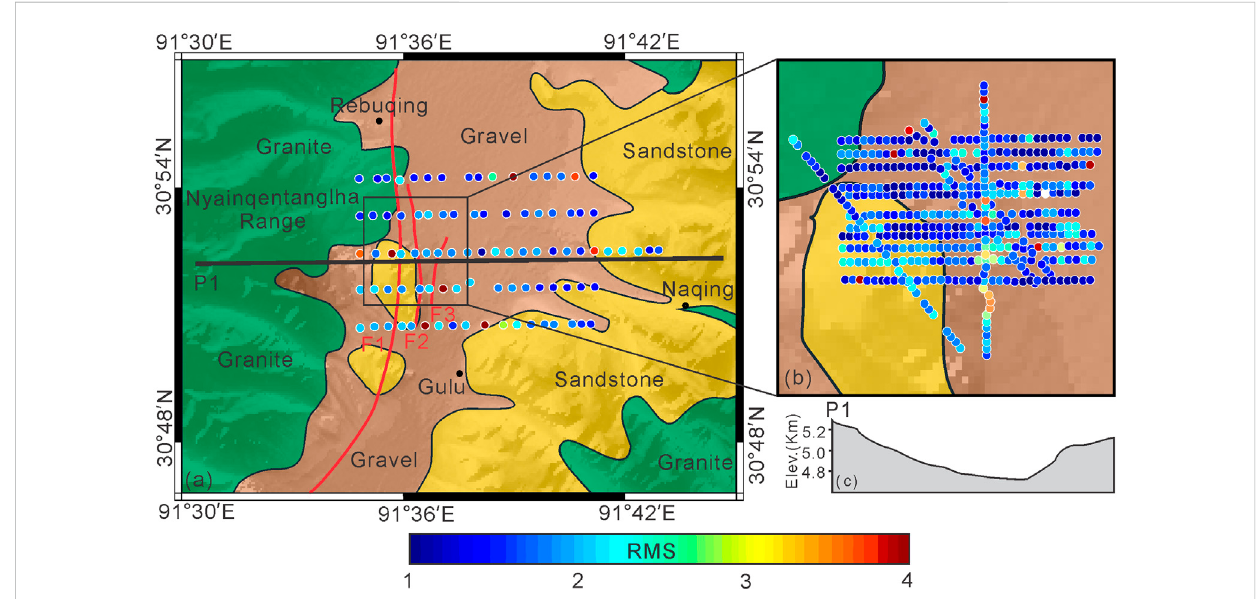
FIGURE 2 RMS of Magnetotelluric 3D inversion and tomographic section. (A) RMS of MT 3D inversion. RMS of most MT sites is less than 3. (B) RMS of AMT 3D inversion.RMSofafewAMTsitesisaround4. (C) TopographicsectionofP1.ThehighterrainonbothsidesofGGFfacilitates fl uidmigrationtothecenter.